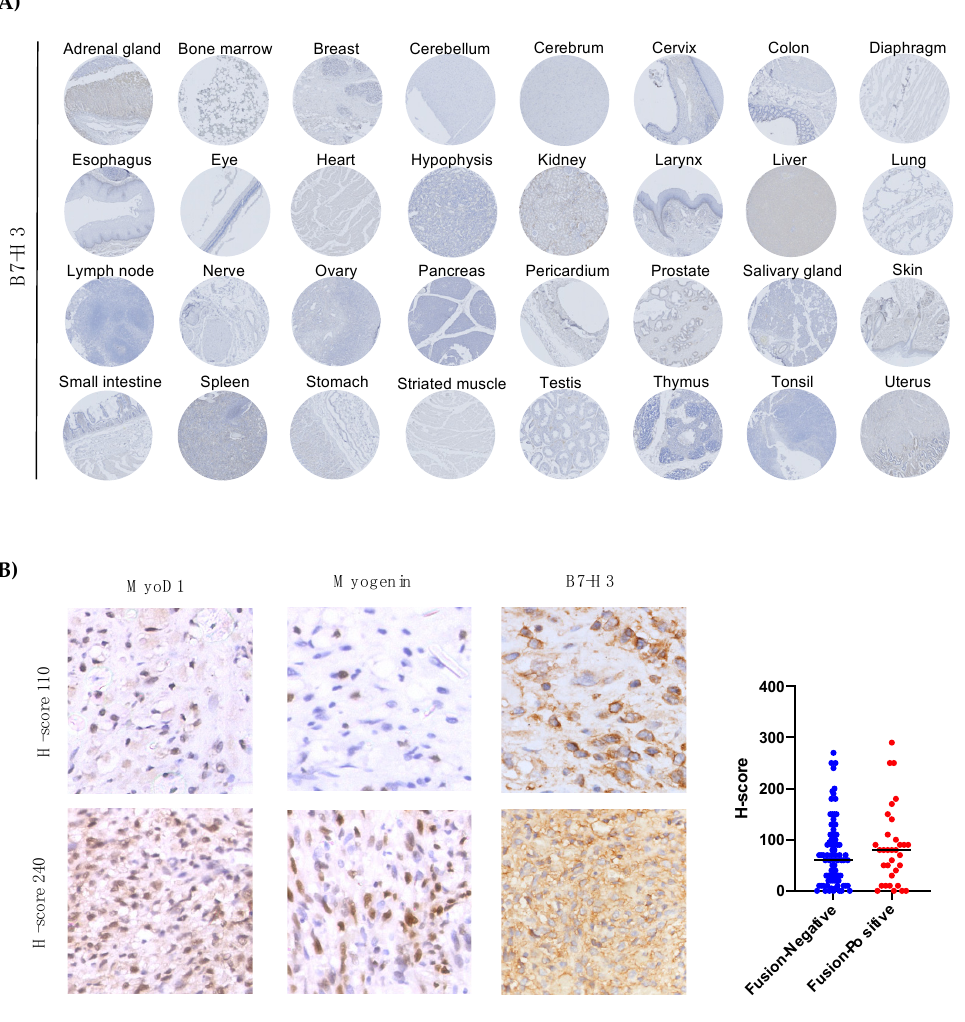
Figure 4. B7-H3 tissue expression in normal organs and RMS tumor specimens. ( A ) Immunohisto- chemical staining of B7H3 in a microarray of 32 normal tissues. Representative picture of triplicates for each tissue. ( B ) Representative picture of immunohistochemistry for MyoD1, Myogenin and B7H3 in RMS tumors. Scatter plot shows quantification of B7-H3 expression using H-scoring system in fusion-negative and fusion-positive RMS tumors (N = 132).